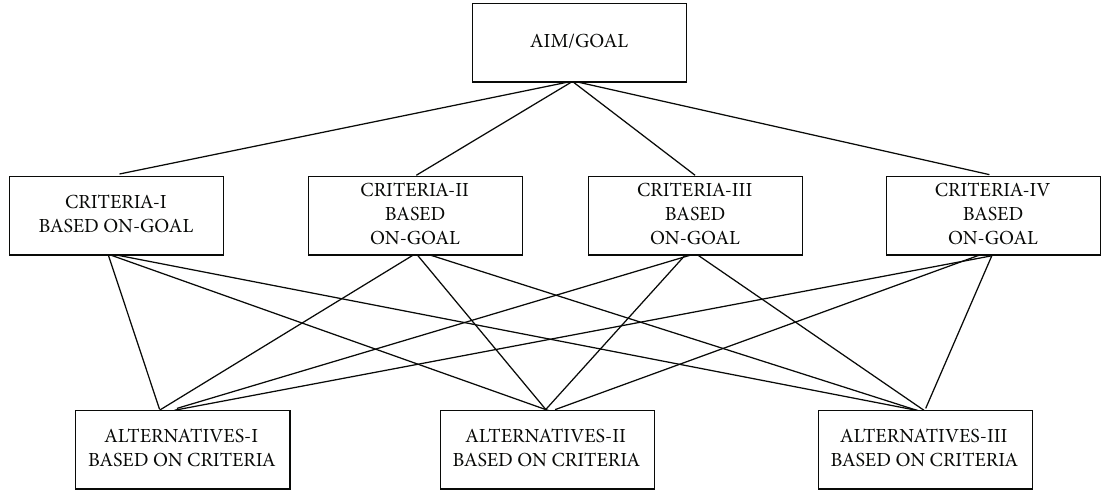
Figure 2: Hierarchy structure of multicriteria decision-making